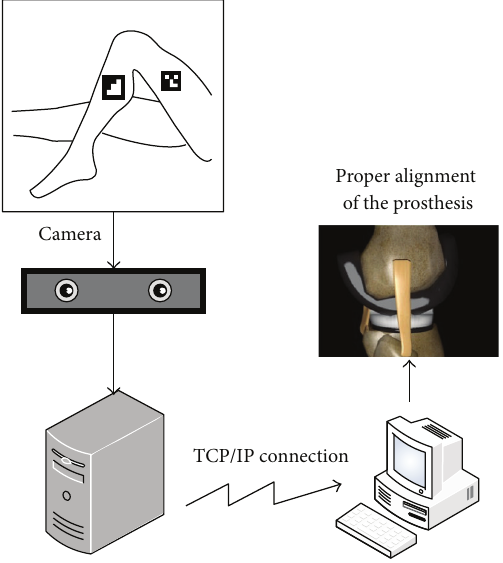
Figure 1: General diagram of the